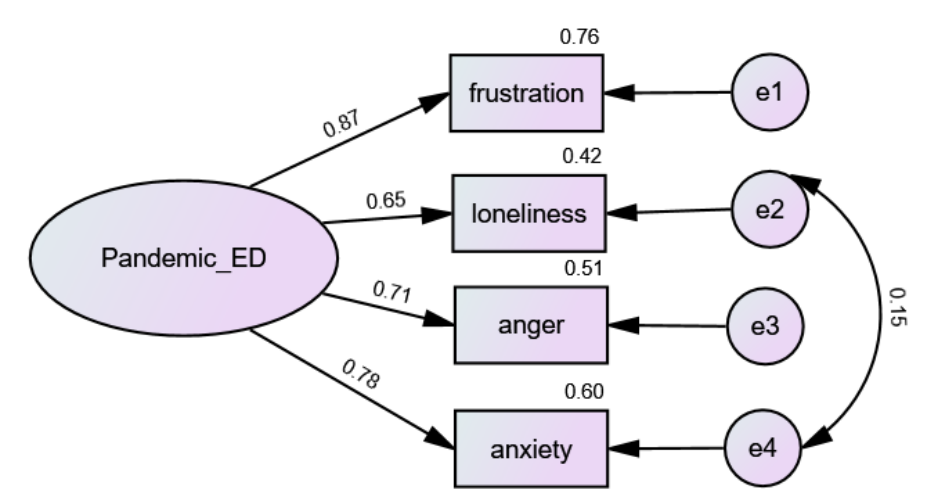
Figure A1. Pandemic Emotional Difficulties model (n = 1405).